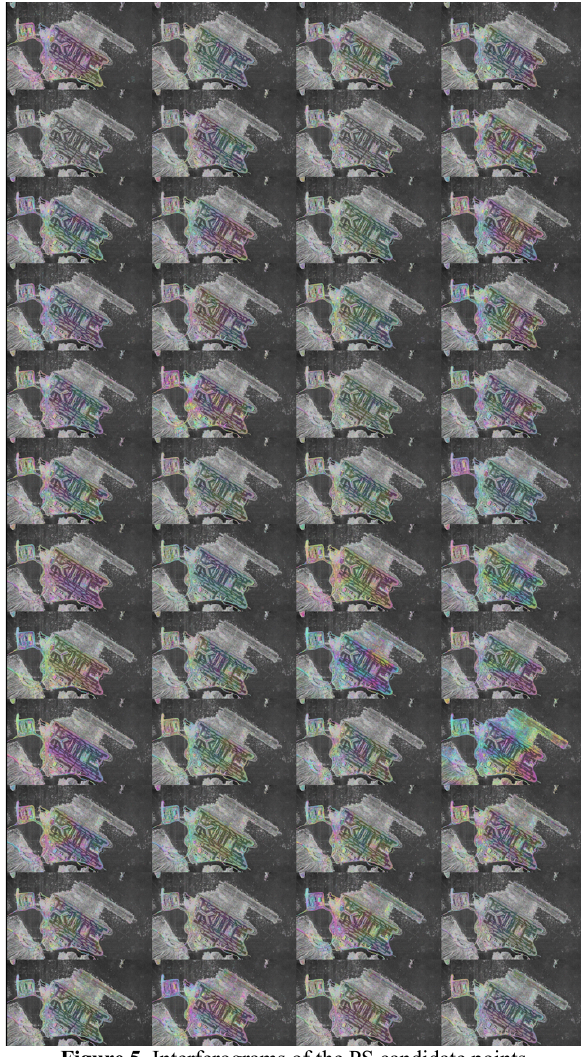
Figure 7 . settlement velocity of the study